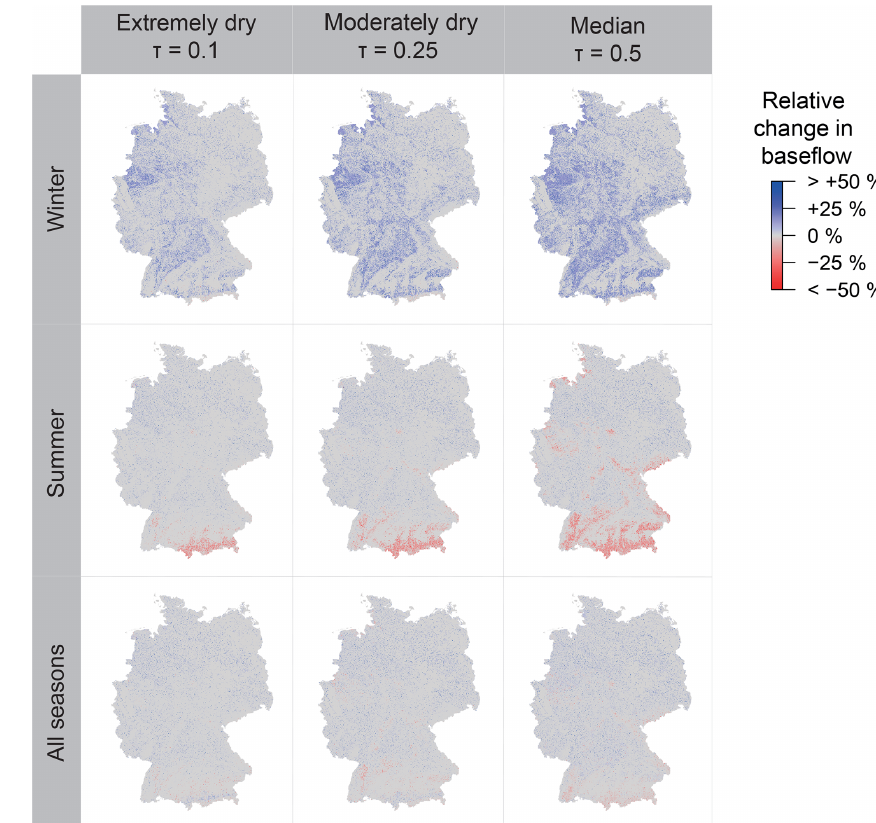
Figure 6. Same as Fig. 5 for relative changes of baseflow.